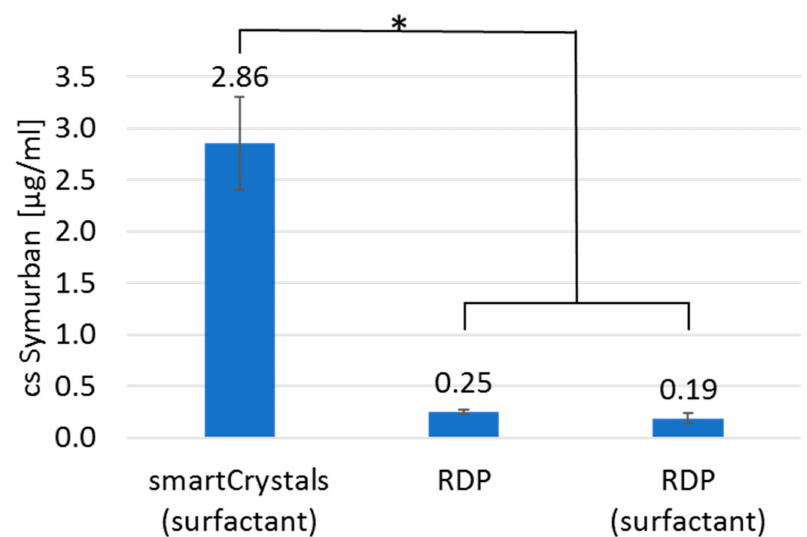
Figure 5. Saturation solubility of Symurban as nanocrystals and raw drug powder (RDP) in water and in aqueous surfactant solution according to the composition of nanocrystal suspension, demonstrating at least an 11-fold increased saturation solubility by nanocrystal